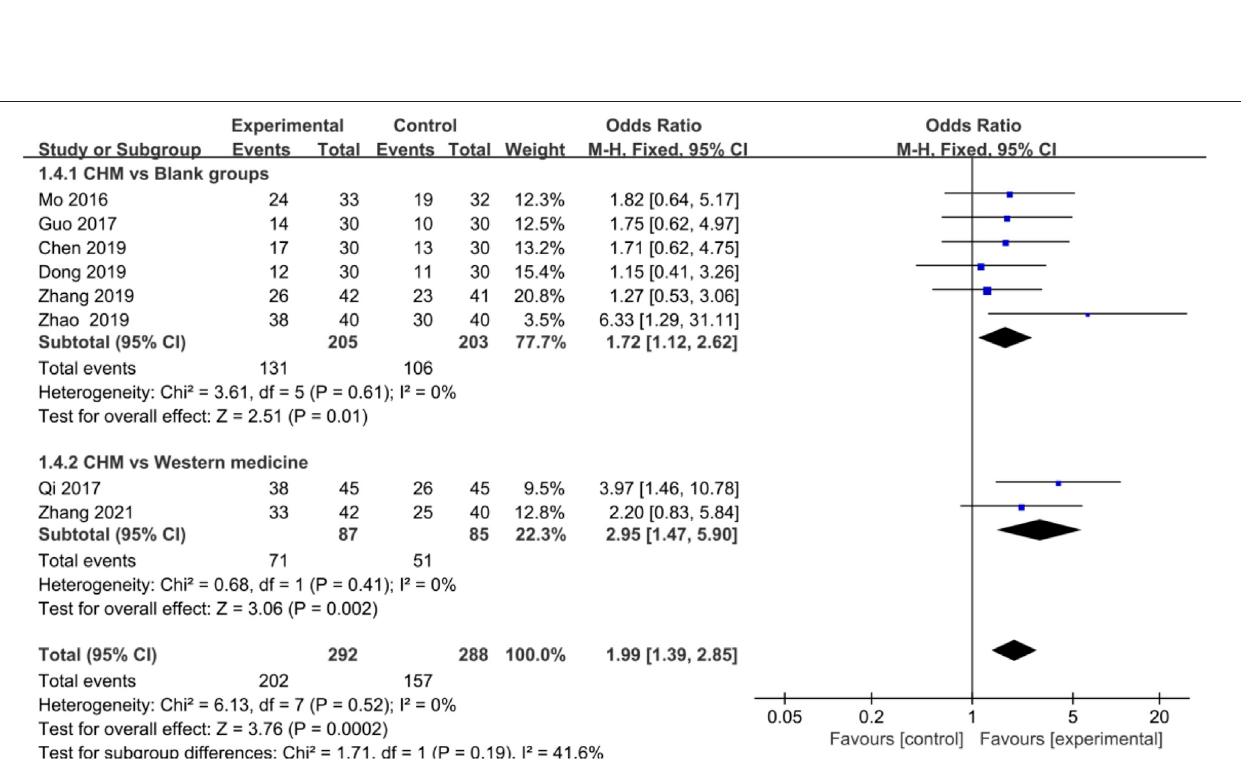
Frontiers in Pharmacology |